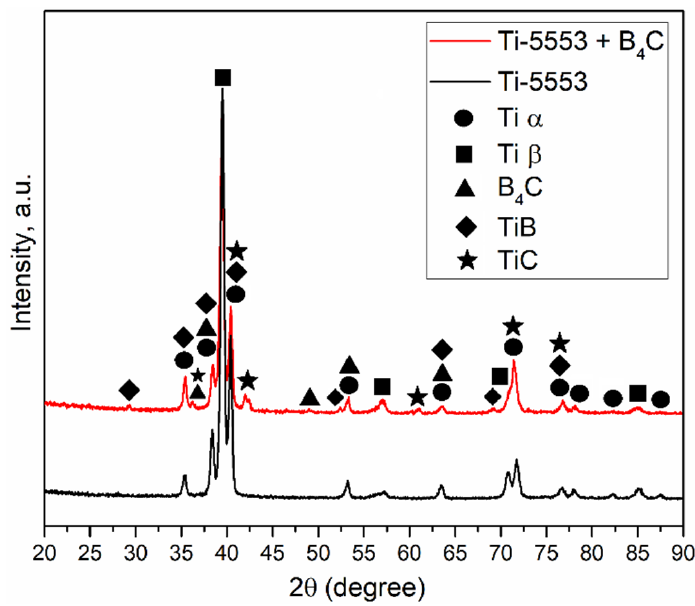
Figure 3. XRD patterns of the Ti-5553 matrix alloy and composite with the addition of B 4 C. The optical microstructures of reference material and in situ reinforced